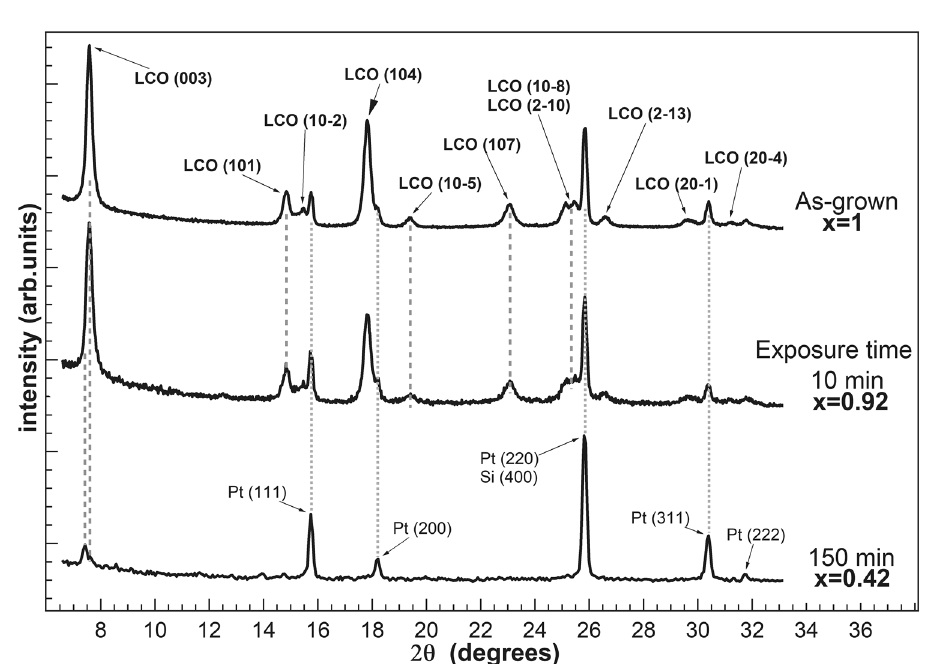
Figure 4. X-ray powder diffraction spectra corresponding to the as-grown LCO structure (top) and to samples delithiated 10 min (center) and 150 min (bottom) in 10 –2 M oxalic acid. Reflections are indexed in the hexagonal structure. Residual reflections from the Pt layer underneath the LCO film and the Si substrate are